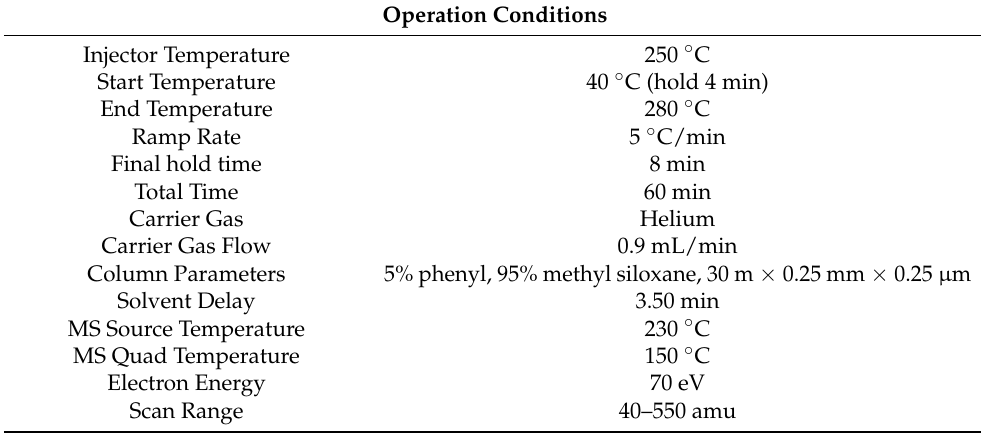
Table 6. The GC-MS conditions used for the analysis of the four MOS oil